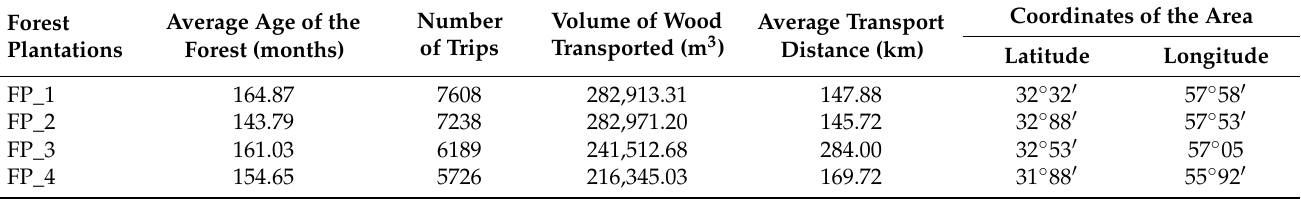
Table 1. Description of attributes corresponding to planted forests in the western region of